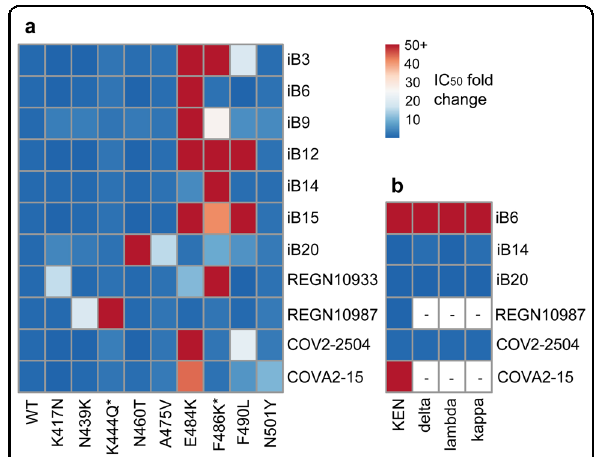
Fig. 5 Neutralization pro fi les for the iB-series of nAbs as well as for some of the previously reported reference nAbs tested against WT and selected amino acid residue mutant pseudoviruses (positions 406 – 501 aa). a Heatmap displaying nAb IC 50 fold change, when tested against a single amino acid mutant virus relative to WT. Asterisks denote mutations that are absent from the currently circulating viral isolates and which have been shown to confer resistance to some of the clinical-stage nAbs. b Heatmap displaying nAb sensitivity to double and triple mutations in the RBD, which correspond to the substitutions found in several currently circulating